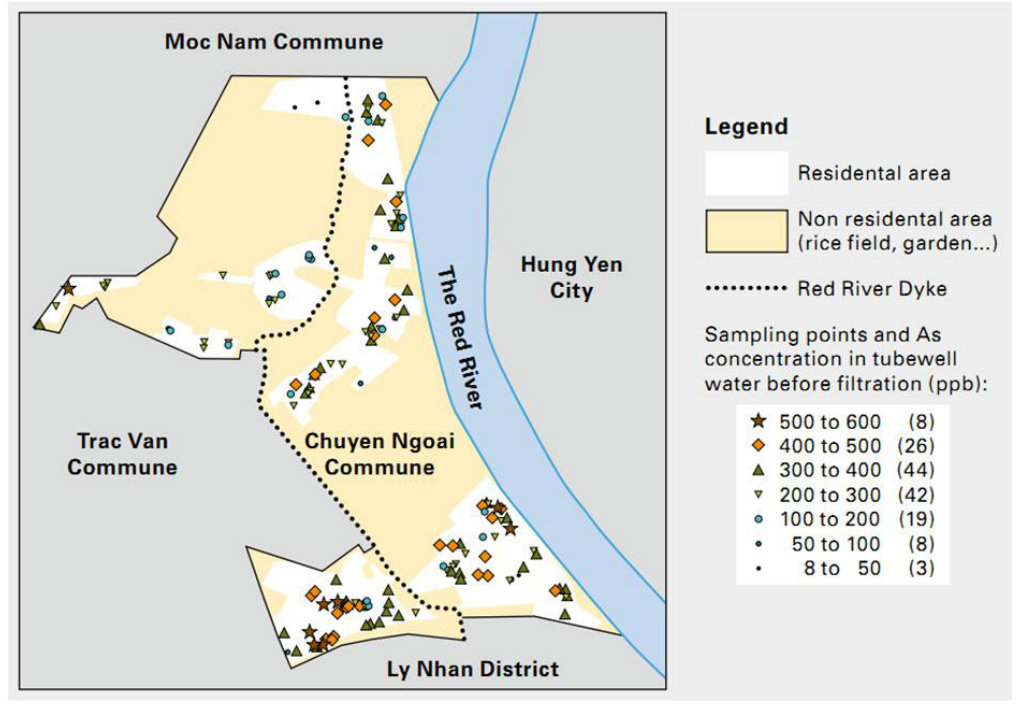
Figure 1. Sampling site and As contamination (before filtration) in the Chuyen Ngoai